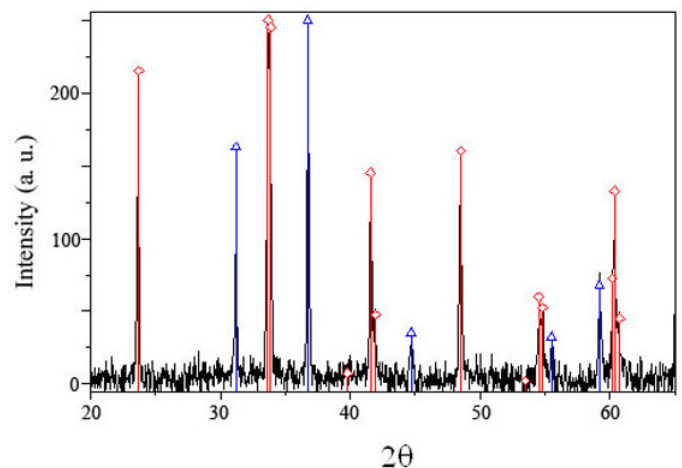
Figure 3. X-ray diffraction pattern of CoAl